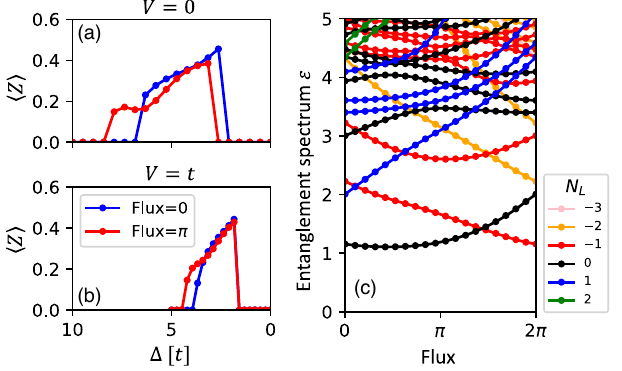
Z FIG. 8. Total Z ¼ Z as a function Δ shown for nearest- A þ B neighbor repulsion (a) V ¼ 0 and (b) V ¼ t . The physics is qualitatively similar, except it occurs within a smaller range of Δ . In panel (c), we verify the nontrivial topology of this phase in DMRG by computing the particle-number-resolved entanglement spectrum adiabatically as 2 π flux is threaded through the cylinder. We use a maximum bond dimension χ ¼ 800